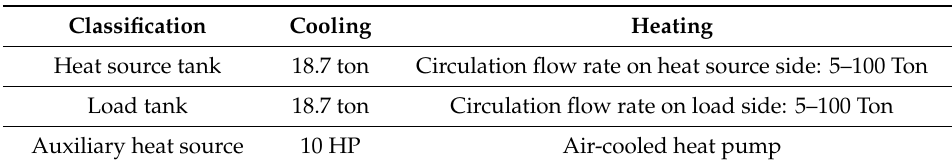
Table 2. Summary of auxiliary system.